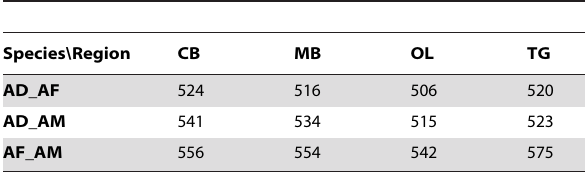
Table 2. Genes showing species by CNS region interaction at p ,